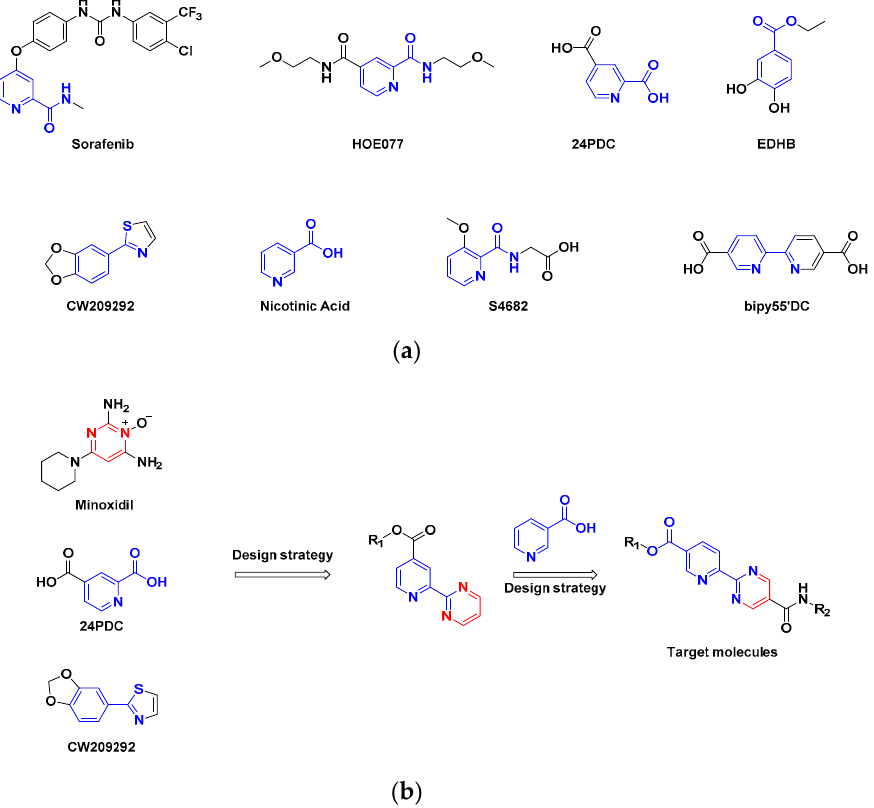
Figure 1. ( a ) Examples of small molecules with similarly active structure fragments; ( b ) design strategy.